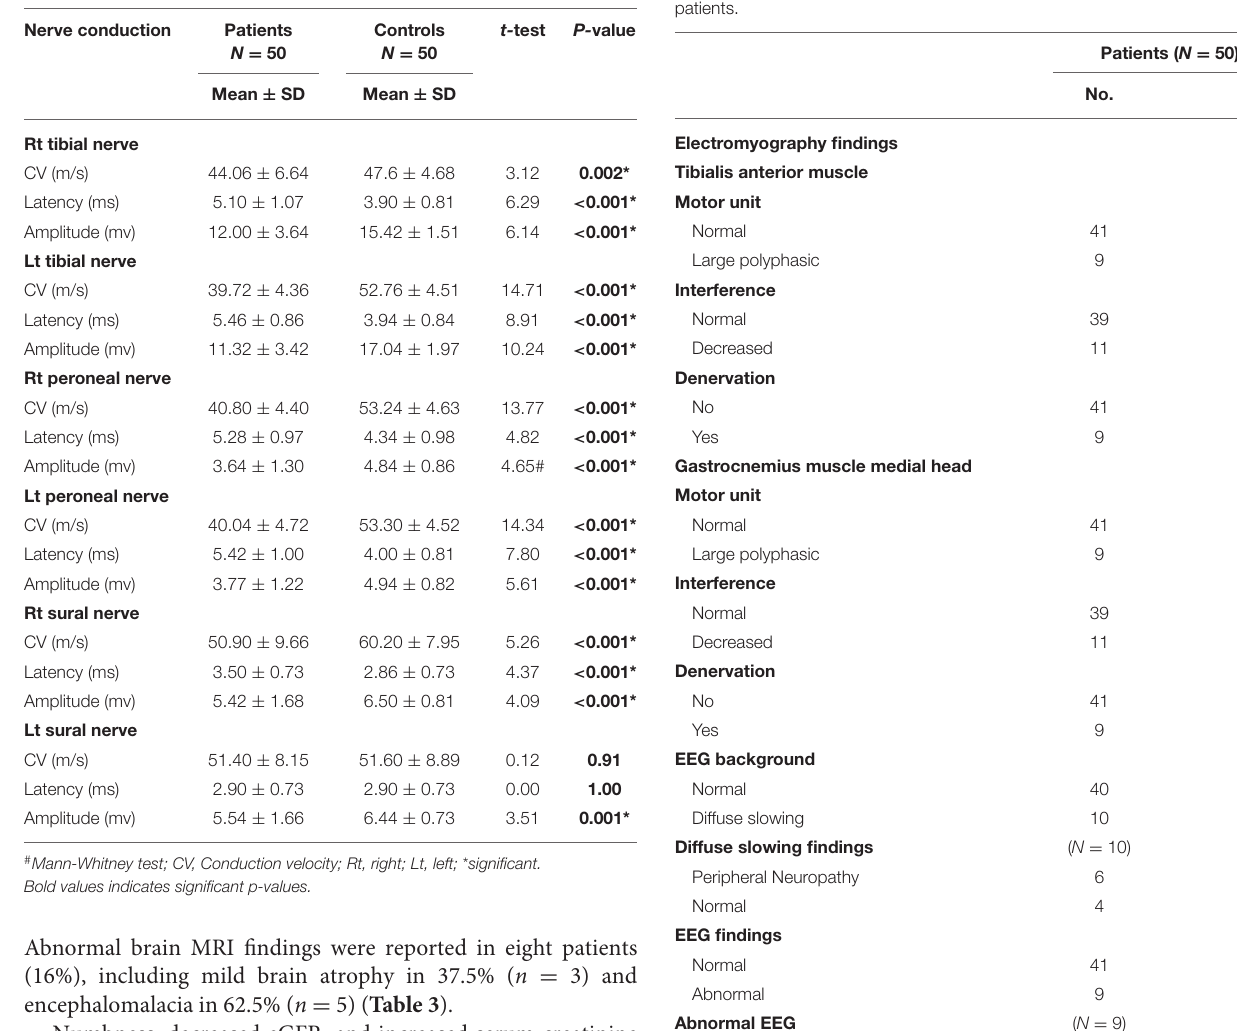
TABLE 3 | Description of Electromyography, EEG, and Brain MRI findings among patients.